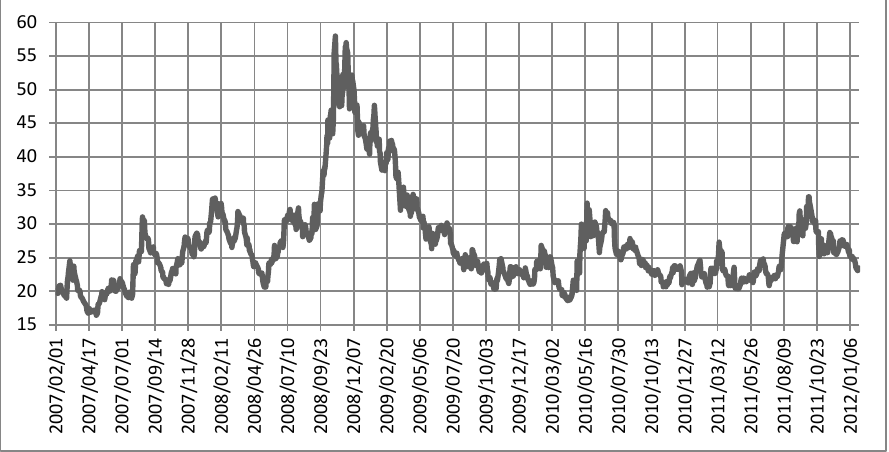
FIGURE 1: The SAVI index from January 2007- January 2012 Source: McGregor BFA database